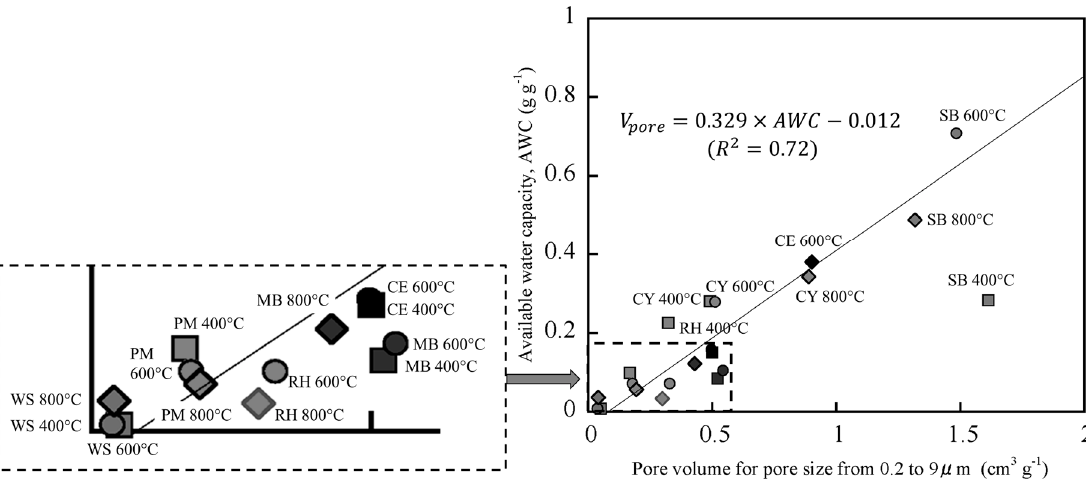
Figure 4. Plot of volumes of pore size from 0.2 µ m to 9 µ m and available water capacity (AWC) of biochar. AWC was calculated from water retention curves (WRCs) of biochar samples [44] reproduced from the reference, copyright 2019, CC-BY-4.0.